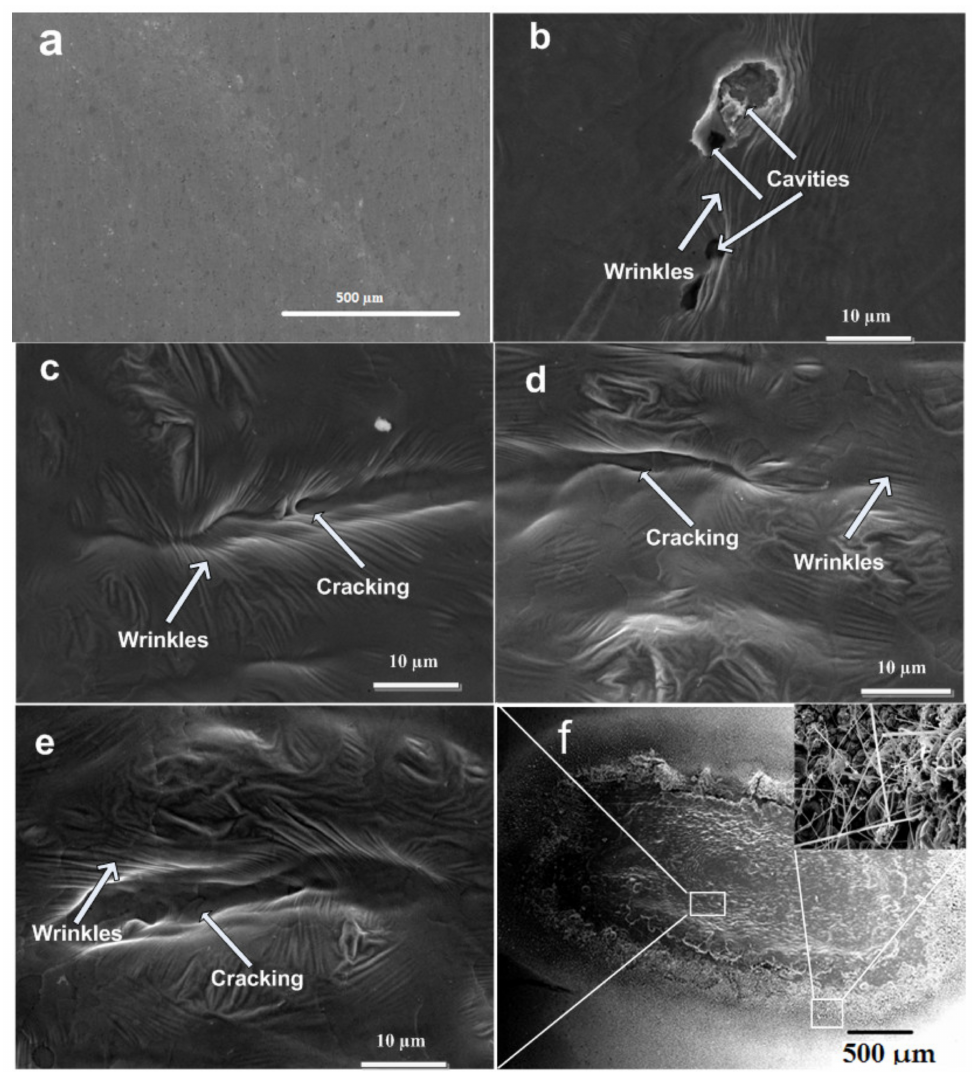
Figure 2. SEM topographical images at center of laser-ablated areas of Cd targets. ( a ) Unirradiated, and irradiated Cd targets for ( b ) 500, ( c ) 1000, ( d ) 1500, ( e ) 2000 laser pulses, and ( f ) full view of ablated region at constant fluence of 3.6 J cm − 2 in